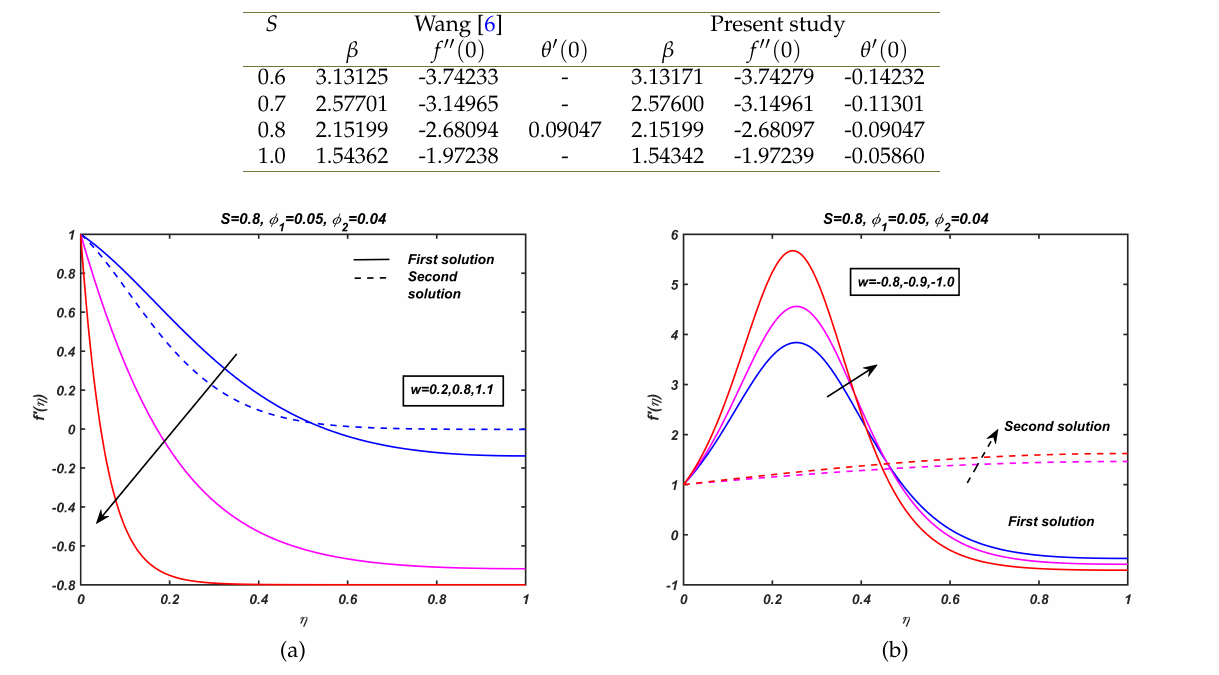
Fig. 3. Effect of w on velocity for suction case (a) and injection case (b) temperature profiles in either suction or injection